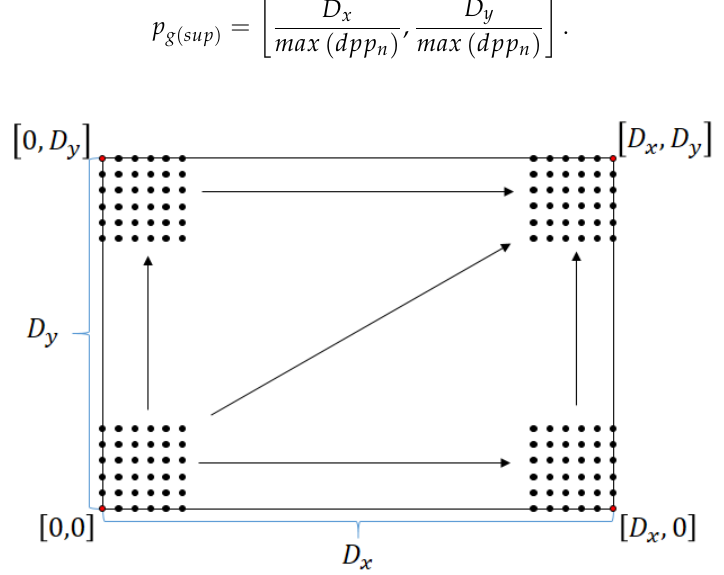
Figure 4. Odometry point